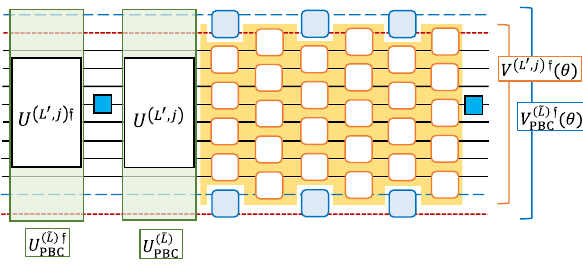
FIG. 5. A schematic version of Fig. 4(b) for translationally invariant systems under PBC. The blue and red solid lines, respectively, represent identical